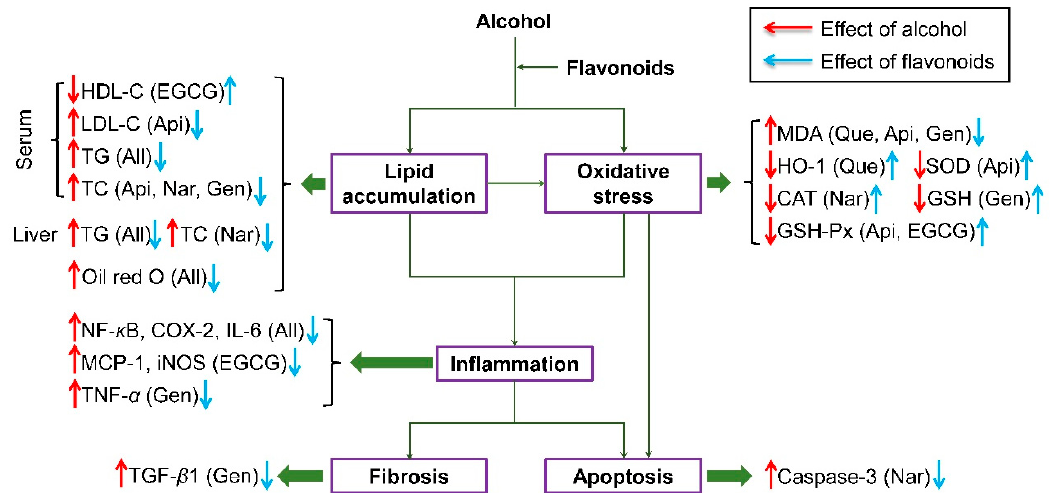
Figure 8. Schematic diagram of the hepatoprotection of five kinds of flavonoids against liver injury induced by chronic alcohol consumption. Que, quercetin; Api, apigenin; Nar, naringenin; EGCG, epigallocatechin gallate; Gen, genistein.